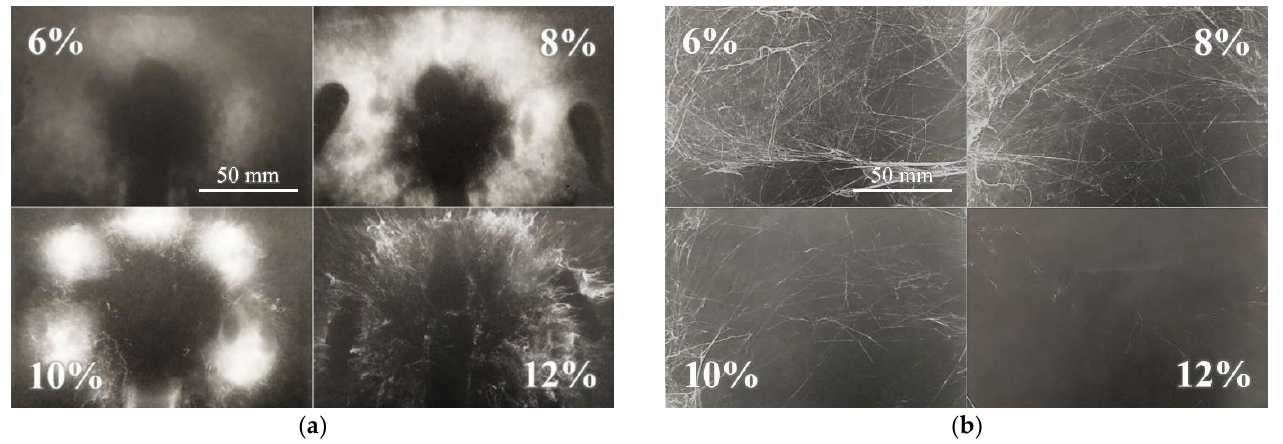
Figure 2. Macroscopic view of the DC electrospinning of PA11 ( a ) illustrates the increasing distinct- ness and collateral separation of the spun layers (the scale from the first image applies to all the images). Example of an AC electrospun sample ( b ) — PA6|6 exhibited a similar spinnability trend to the PA11 spun via DC technology.